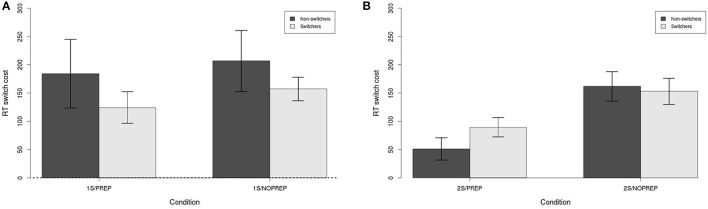
Switch cost (RT) in each condition. (A) Block 6 in 1-session conditions. (B) Block 13 in 2-sessions conditions. All switch costs in all panels are statistically significant (p < 0.05). Error bars are between-subject standard error of the mean.